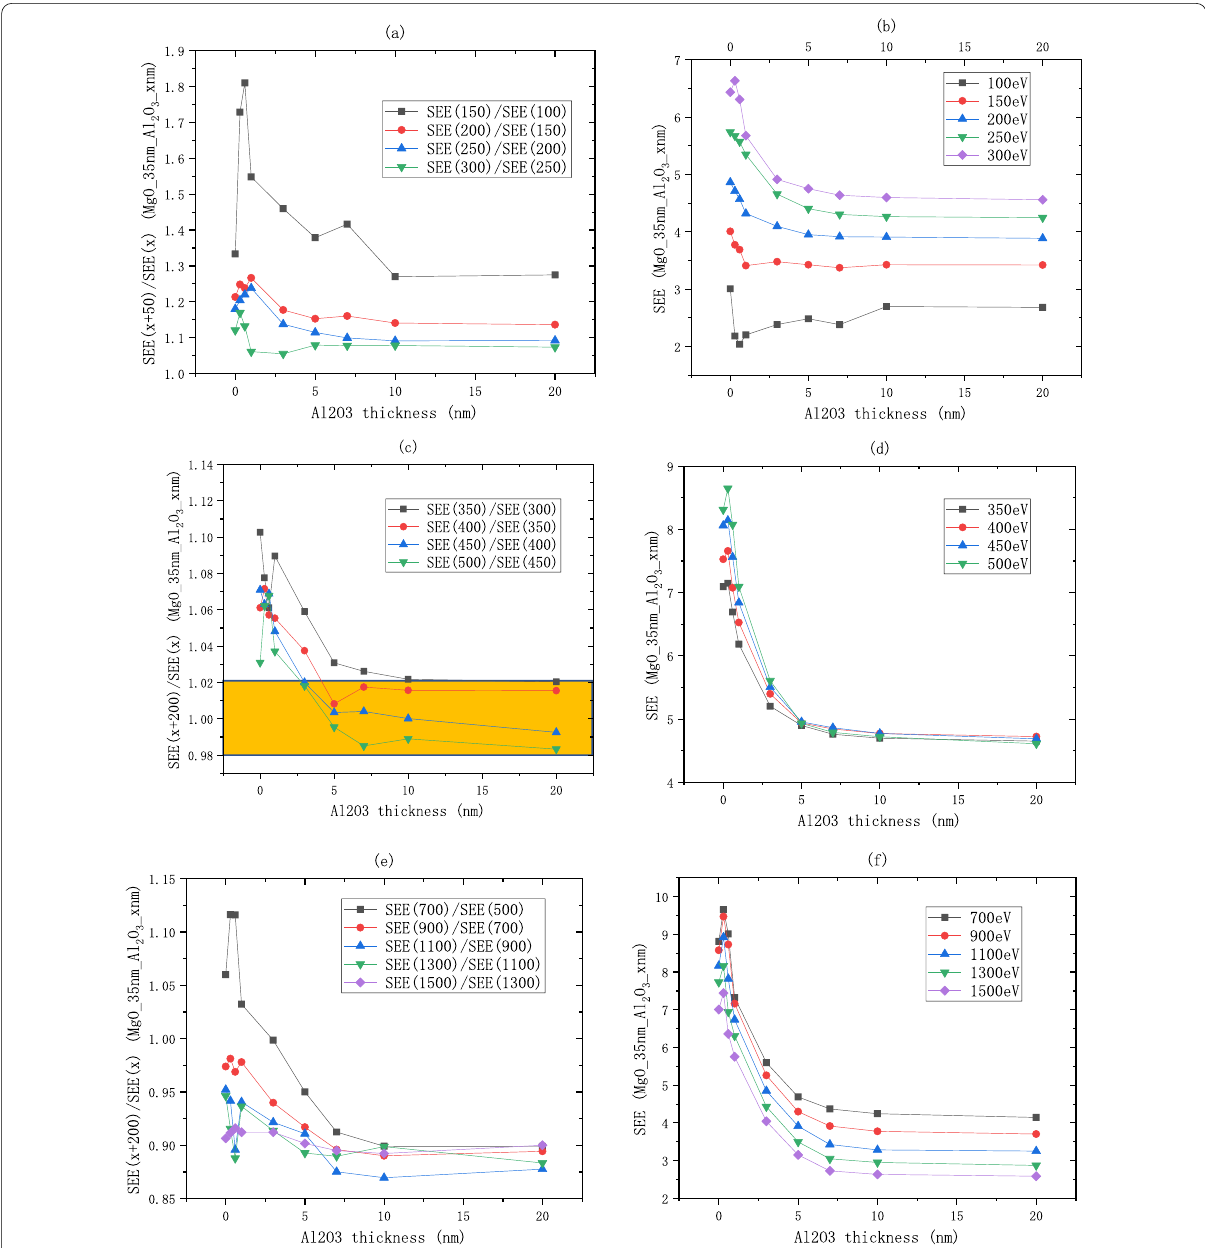
Fig.10 After dividing the incident electron energy by R SEE = SEE(x+b) SEE(x) as shown in the a, c, e , the change of MgO/Al 2 O 3 (on the silicon wafer, grow 35 nm-MgO, and then grow xnm-Al 2 O 3 ) SEE with thickness as shown in the b , d,